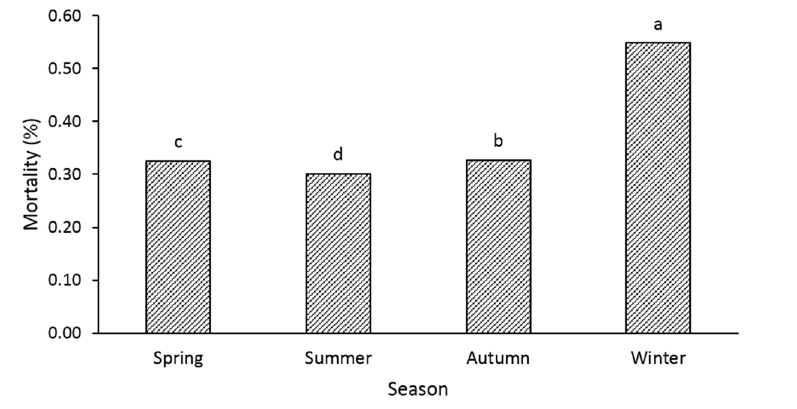
Figure 3. Transport-related mortality of broiler chickens as affected by the season of the year. a-d Mortality in columns with different superscripts differ significantly